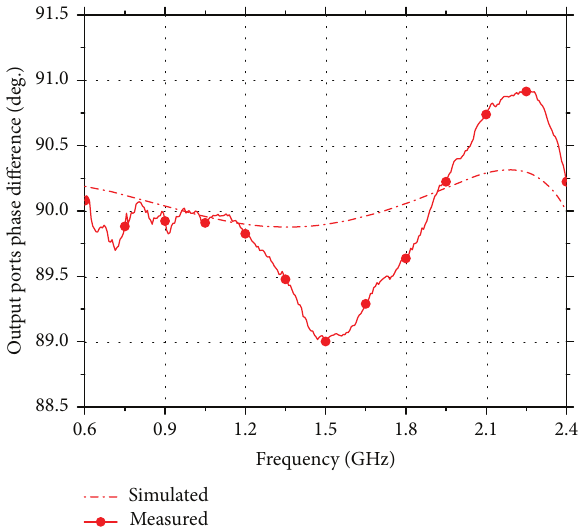
Figure 7: Simulated and measured output ports phase difference of the 7dB coupler configured with the PCMLFGPC.